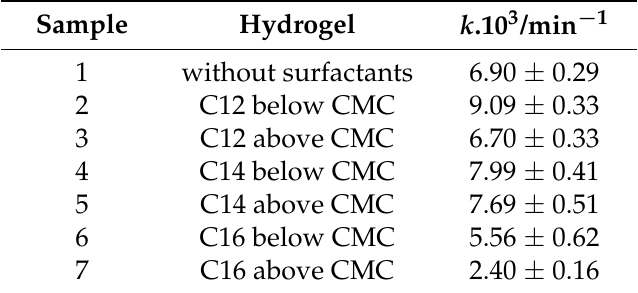
Table 2. Release rate constants of CHX from hydrogels.